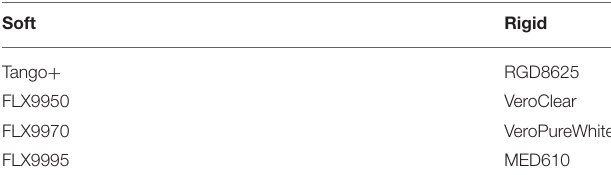
TABLE 1 | List of studied materials and classification in soft and rigid ones.